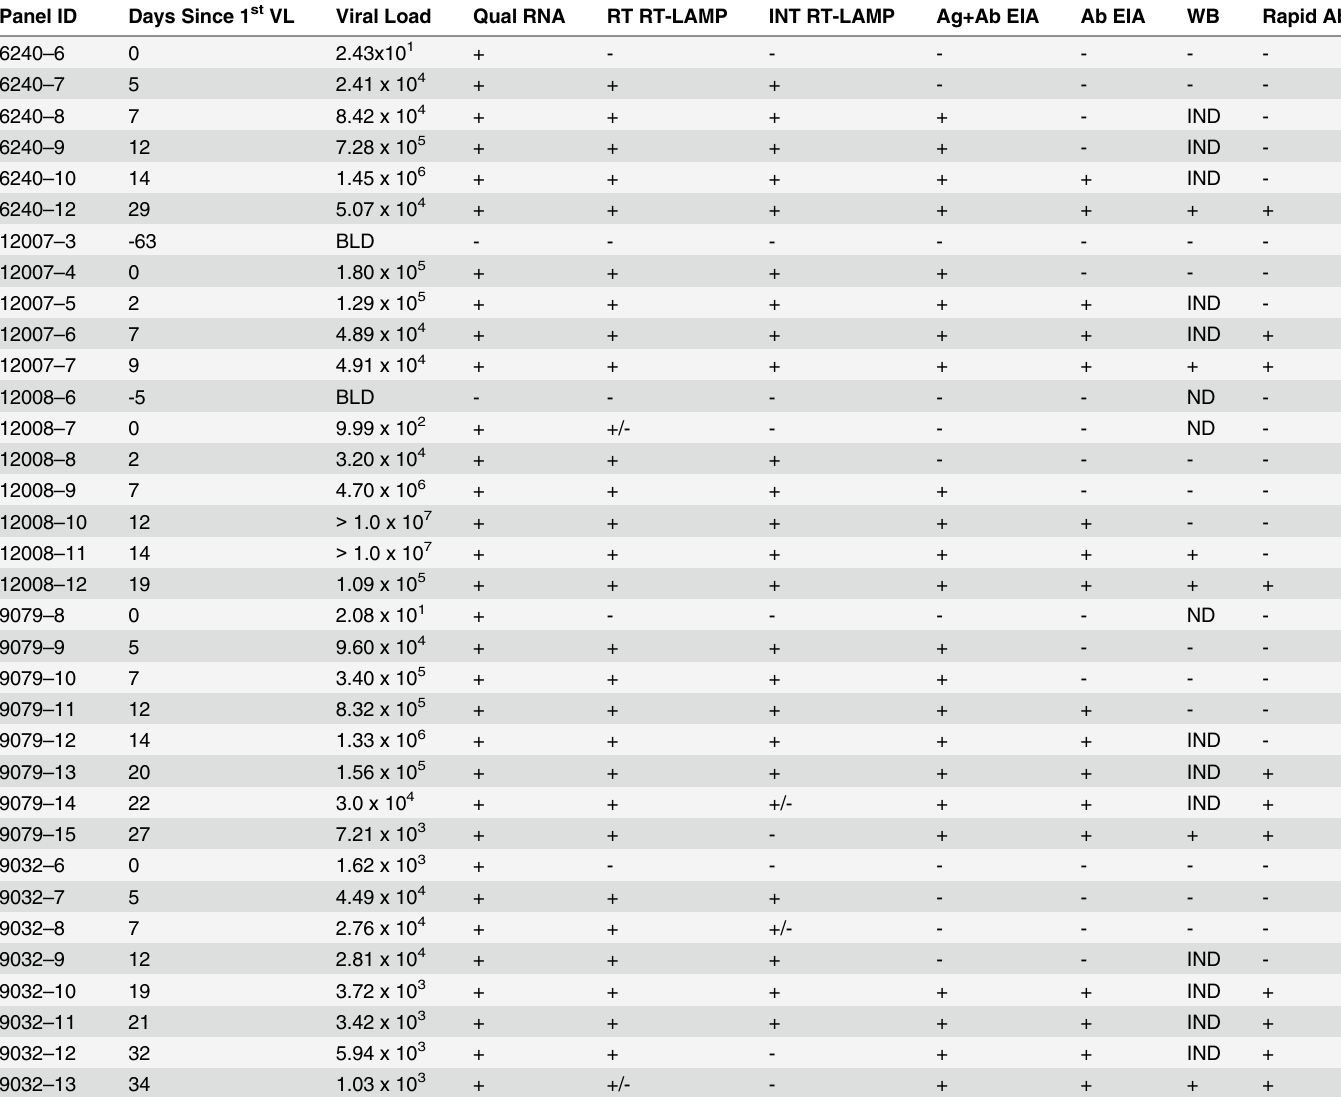
Table 3. Evaluation of RT-LAMP Assay with Zeptometrix Seroconversion Panels. Panel